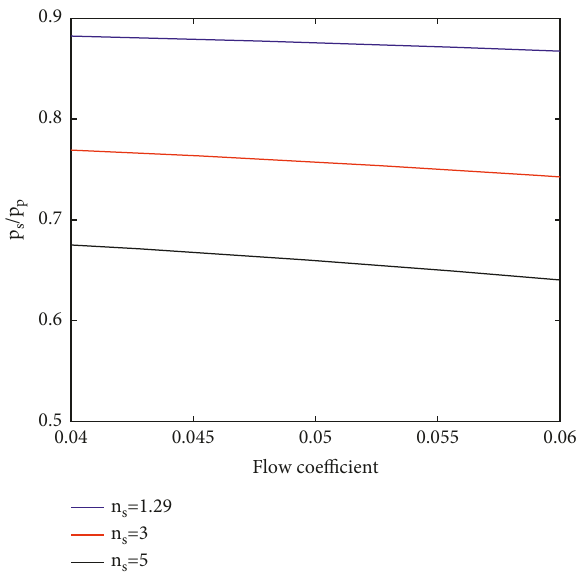
Figure 9: Static pressure ratio at the tip of the impeller leading